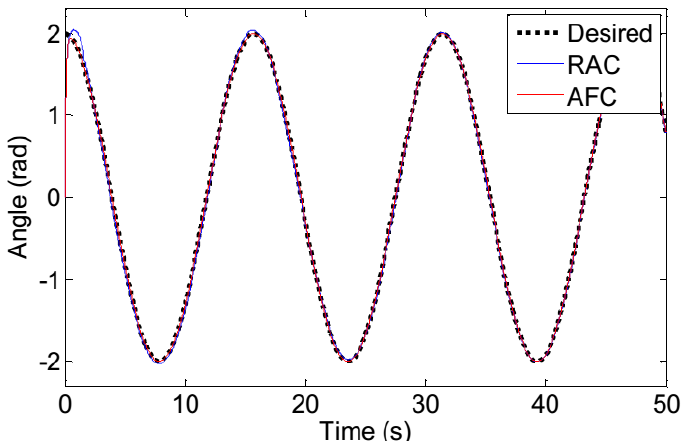
Figure 4. The tracking performance of the two controllers for the angle of the second joint of the arm.